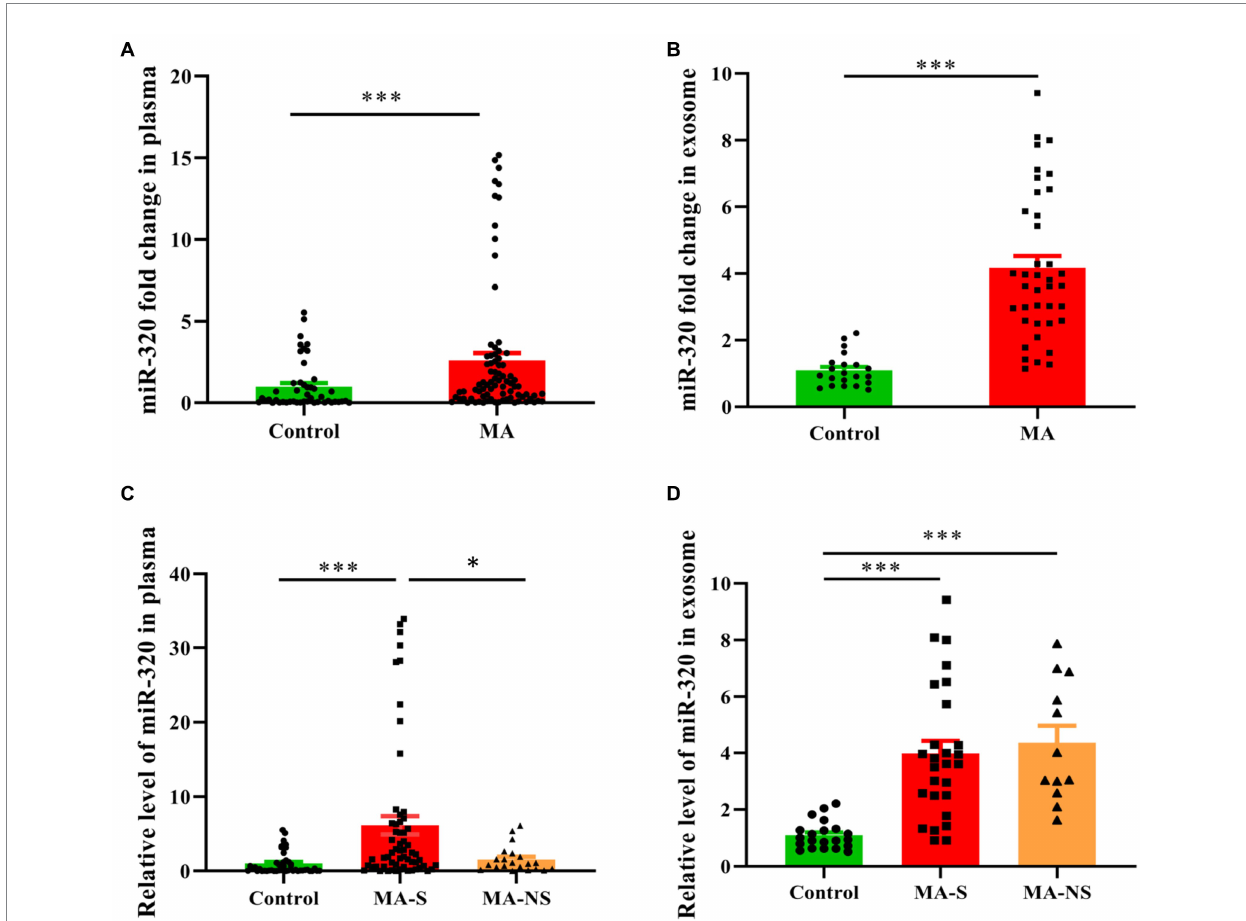
FIGURE 3 Expression of miR-320 in the plasma and exosomes from MA patients and healthy controls. (A) Patients with MA use disorder showed a significantly higher expression of miR-320 than healthy controls in plasma (Mann–Whitney U -test; n = 50 in control, n = 82 in MA use disorder, *** p < 0.001). (B) Patients with MA use disorder showed a significantly higher expression of miR-320 than healthy controls in exosomes (Mann–Whitney U -test; n = 21 in control, n = 39 in MA use disorder, *** p < 0.001). (C) Smoking significantly affected plasma miR-320 levels in MA use disorder patients (Kruskal– Wallis H test; n = 50, 61, and 21 in control, MA-S, and MA-NS groups, respectively. Con vs. MA-S, adjusted p < 0.001; MA-S vs. MA-NS, adjusted p = 0.019). (D) Smoking did not significantly affect plasma miR-320 in MA use disorder patients (Kruskal–Wallis H test; n = 21, 27, and 12 in control, MA-S, and MA- NS groups, respectively, Con vs. MA-S, adjusted p < 0.001; Con vs. MA-NS, adjusted p < 0.001.). Data are expressed as the mean ± SEM. ** p < 0.01 *** p <